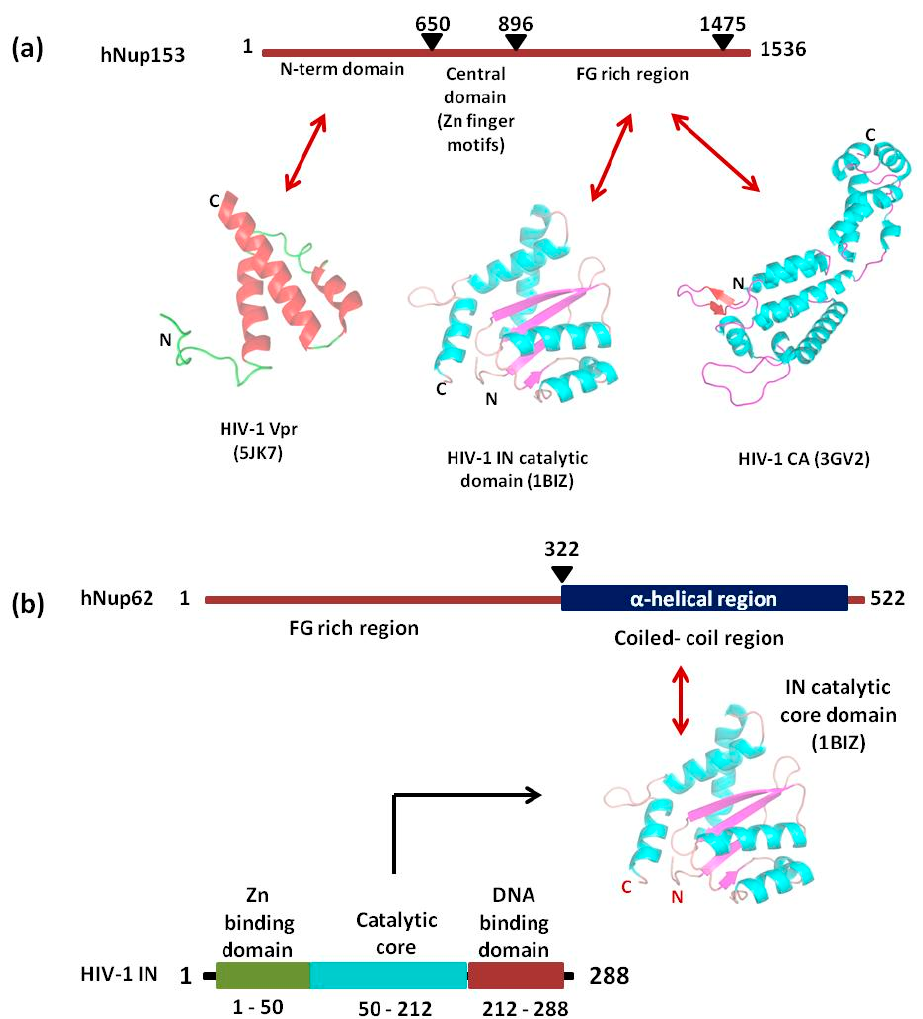
Figure 6. Schematic representation of interacting regions of Nup153 ( a ) and Nup62 ( b ) with different HIV-1 proteins.